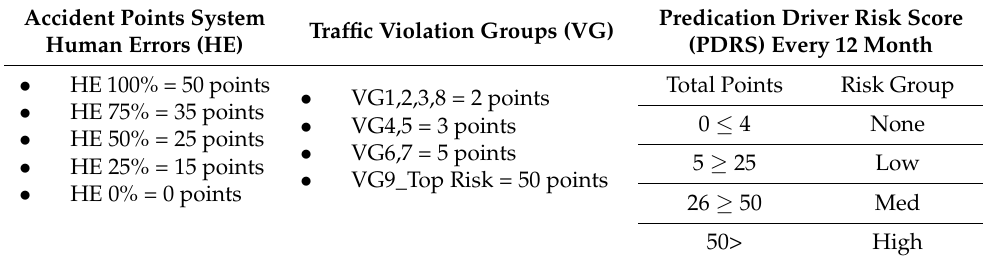
Table 1. Driver risk metrics based on the STPSR system.